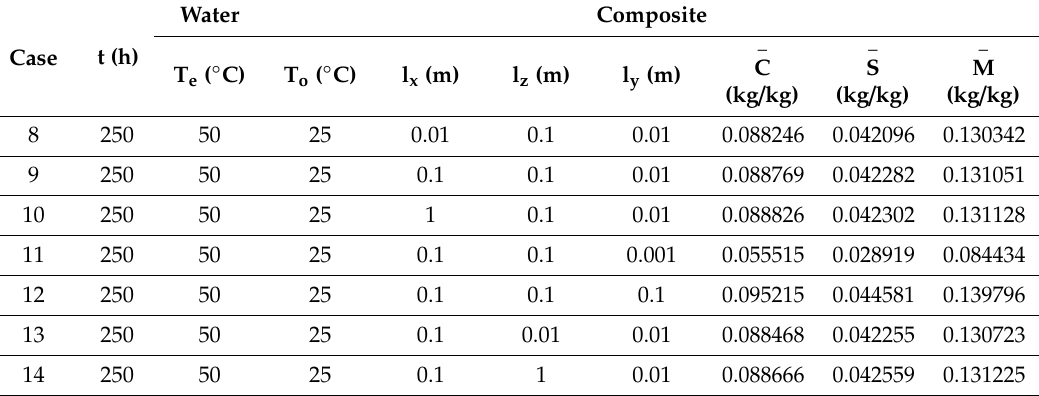
Table 5. Langmuir absorption parameter values found for t = 250 h and di ff erent l x , l y , and l z (arbitrary